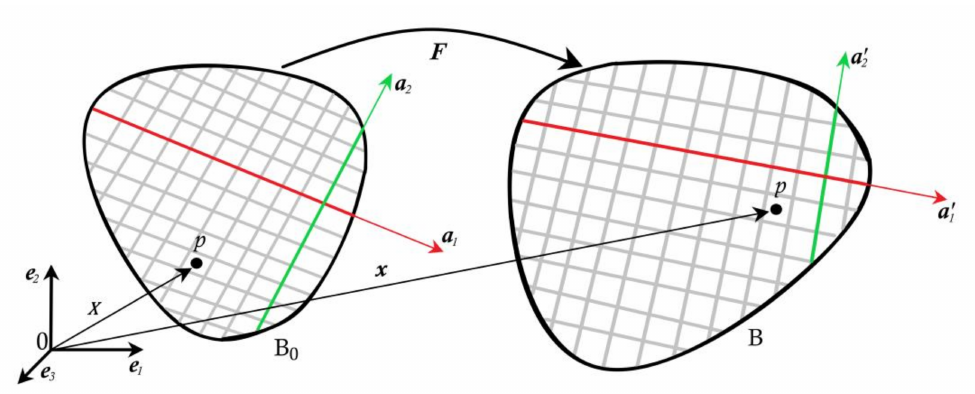
Figure 3. Configuration of the continuum body from reference state to the deformed